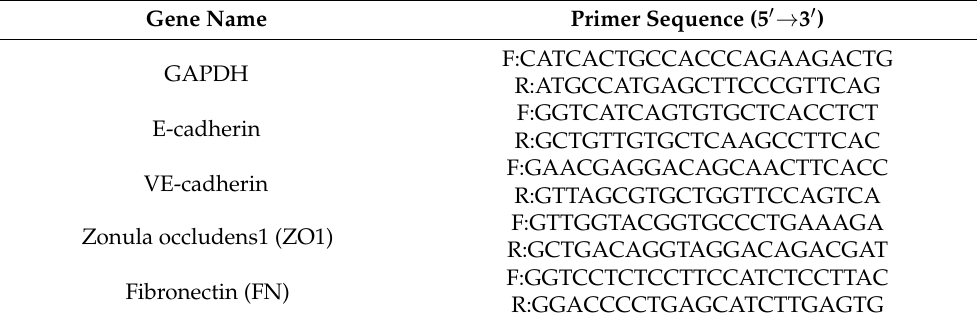
Table 1. Primer sequences for